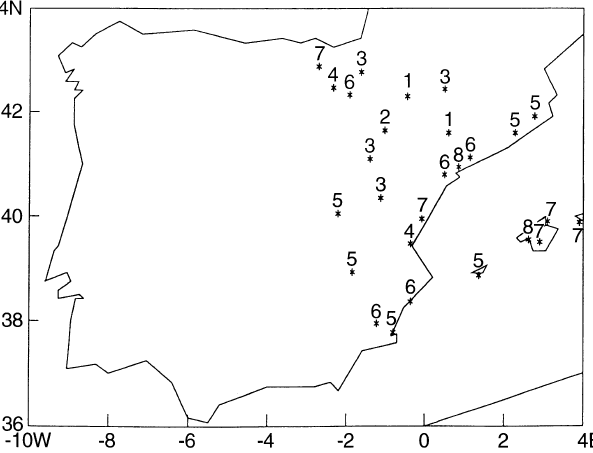
Fig. 3. Spatial pattern of cloudiness for 15 March 1990. Numbers indicate sky covered by cloud in oktas